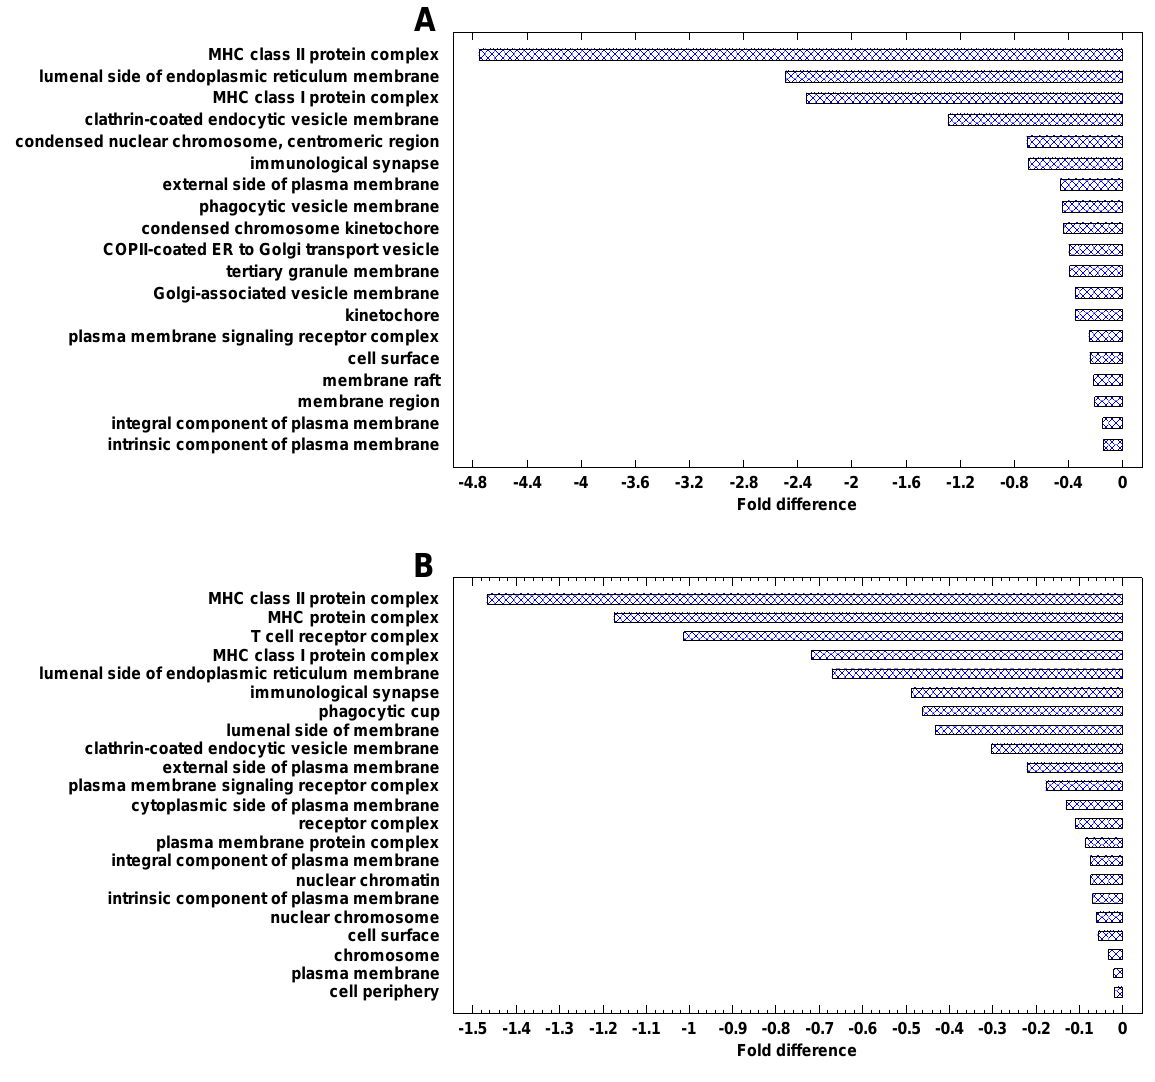
Figure 8. The most strongly enriched GO Cell Components in the genes that are downregulated in cancers. Fold difference: the difference between the mean cancer/normal expression fold for a given cell component and the mean fold for all cell components (log2). The components with the highest folds (and having >10 genes) are shown: ( A ) breast cancer ( p < 0.0001 at least); ( B ) melanoma ( p < 0.01 at least).